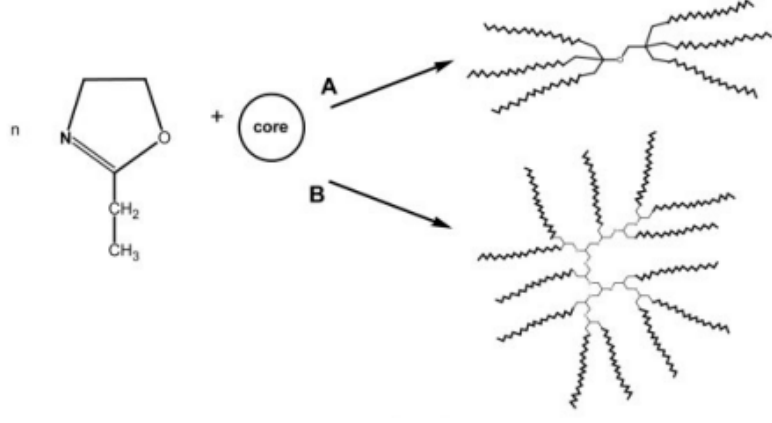
Figure 17. A schematic representation of the synthesis of star-shaped poly(2-ethyl-2-oxazoline)s. Reprinted from [38]. Copyright (2022), with permission from Elsevier [or applicable society copyright owner].